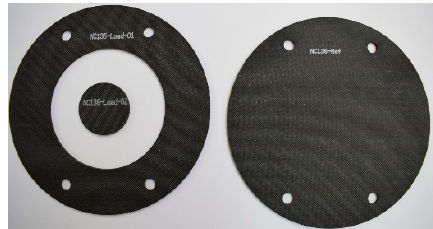
Figure 2. The specimens used in the EMC (electromagnetic compatibility) tests (left: reference; right: load).